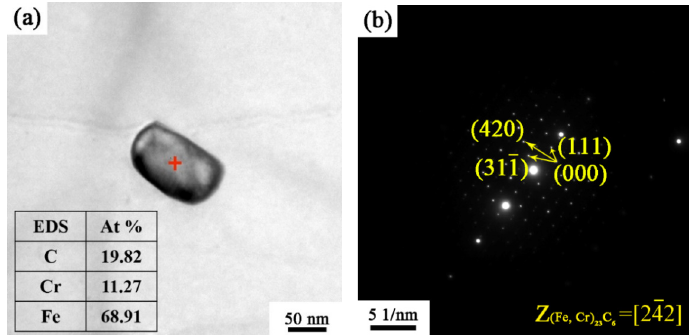
Figure 4. Recrystallization microstructure distribution of X2CrNi12 steel at different annealing tem- peratures with 90% cold-rolling deformation ( a ) deformed; ( b ) 720 °C; ( c ) 740 °C; ( d ) 770 °C. To display the microstructure and composition of the precipitates more clearly, Fig- ure 5a shows the TEM image and the corresponding EDS of the precipitates in the speci- men annealed at 740 °C. It can be seen that the precipitate was mainly composed of Fe, Cr, and C elements. Figure 5b shows the selected area electron diffraction (SAED) pattens of the precipitate in Figure 5a. The EDS result and diffraction pattern provide evidence for the precipitation of (Fe, Cr) 23 C 6 , and display a face-centered cubic crystal structure with a lattice constant of 0.106 nm.